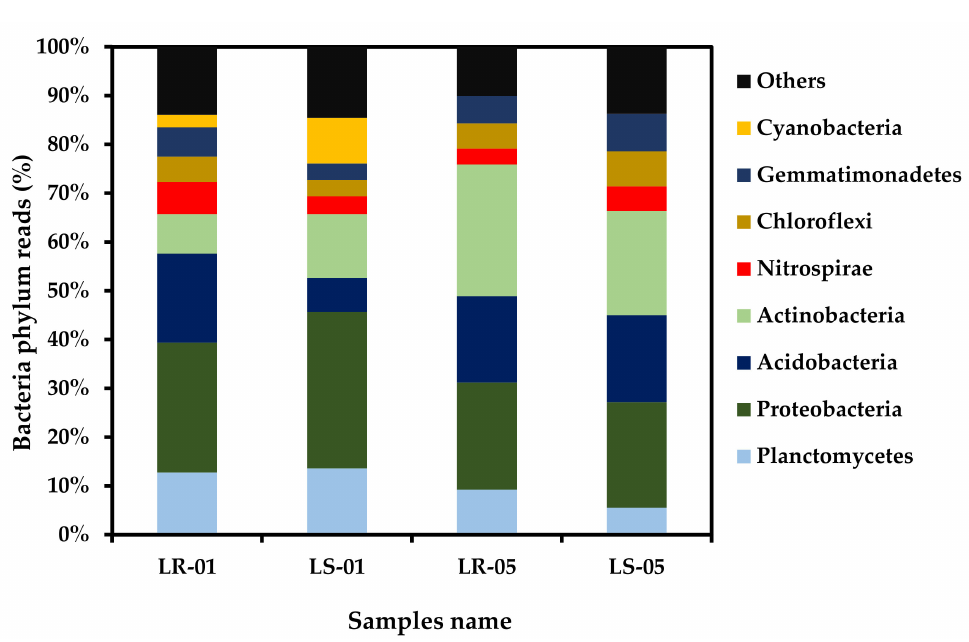
Figure 4. Major bacterial phylum relative abundance of rock and soil samples collected outside the cave (LR-01 and LS-01) and inside the cave (LR-05 and